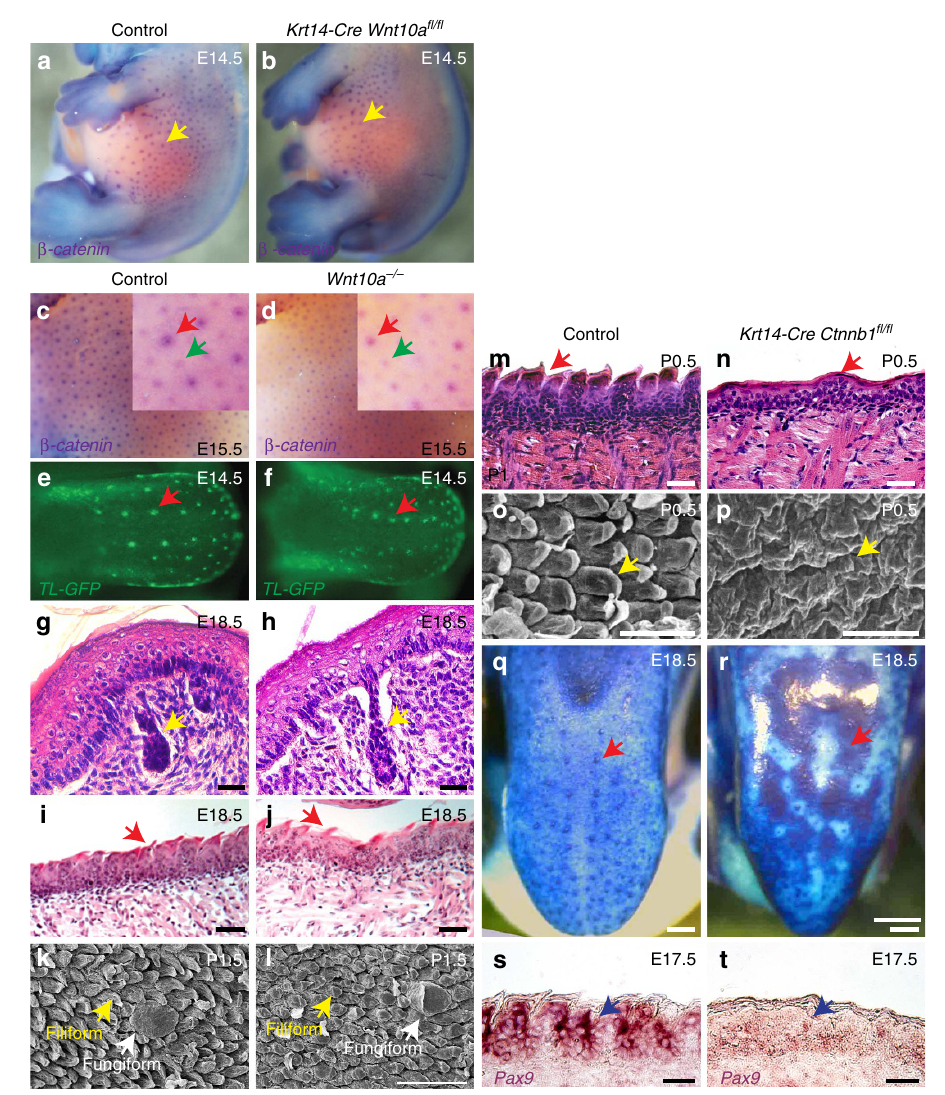
Figure 4 | Wnt10a mutation does not affect embryonic development of HFs or sweat glands or tongue papillae. ( a – d ) Whole-mount in situ hybridization of control and Wnt10a mutant embryos at the indicated time points using DIG-labelled probe for b -catenin, an HF placode marker (purple signal), reveals that early stages of HF development are unaffected by constitutive epithelial ( a , b ) or global ( c , d ) deletion of Wnt10a . ( e , f ) TL-GFP expression in tongue whole mounts at E14.5 shows that fungiform taste papilla placodes and Wnt/ b -catenin signalling (arrows) are not affected by global loss of Wnt10a . ( g – j ) H&E staining at E18.5 reveals normal initiation of sweat gland ( g , h , yellow arrows) and filiform papilla ( i , j , red arrows) development in Wnt10a mutants. ( k , l ) P1.5 Wnt10a mutant tongues display normal fungiform and filiform papillae, assayed by SEM. ( m – p ) Constitutive epithelial b -catenin deletion causes failure of filiform papilla formation at P0.5: H&E staining ( m , n ); SEM analysis ( o , p ). ( q , r ) Constitutive epithelial b -catenin deletion results in defective tongue barrier formation, revealed by dye penetration (dark blue staining), which is confined to fungiform papillae in controls ( q , arrow) but is broadly apparent in mutants ( r , arrow). ( s , t ) In situ hybridization for Pax9 reveals its decreased expression in epithelial b -catenin mutant dorsal tongue (purple/brown signal). N ¼ 3 mutants and n ¼ 3 control mice were analysed in all experiments. Scale bar, 25 m m ( g , h ), 40 m m ( s , t ), 50 m m ( i , j , m – p ), 100 m m ( k , l ) or 200 m m ( q , r